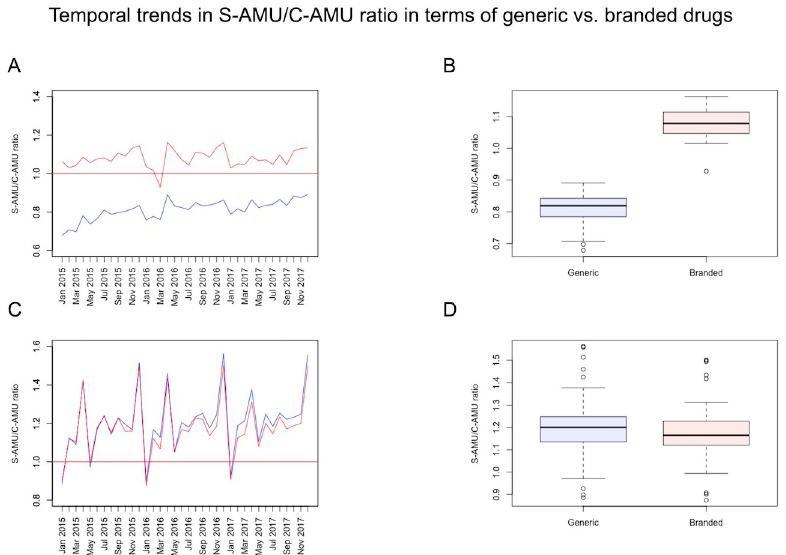
Fig 2. Temporal trends in S-AMU/C-AMU ratio according to generic or branded drugs. Panels A and B show line graphs of SCR trends in oral drugs and parenteral drugs, respectively. The median SCRs of oral branded drugs were higher than 1, but those of generic drugs were lower than 1. Panels C and D show boxplots of monthly SCRs from 2015 to 2017. A significant difference ( P < 0.001) was observed in oral drugs, but not in parenteral drugs ( P = 0.183).